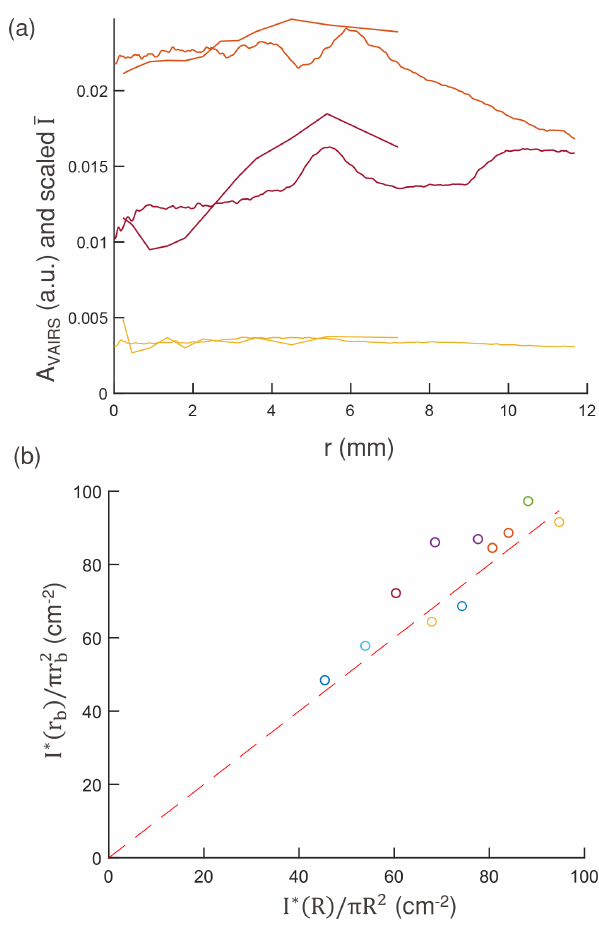
Figure 4. (a) Radial profile of scattered intensities ( I(r) ) obtained from image analysis (Sect. S5) and from VAIRS analysis ( A VAIRS ). I(r) values range to a higher r , have higher resolution than A VAIRS values, and are scaled differently for each sample to display it together with the corresponding A VAIRS profile. (b) Calculated I ∗ (r b )/πr 2 and I ∗ (R)/πR 2 from image analysis for the experi- b ments with different m ∗ a (R) and a 1 : 1 reference line (red dotted